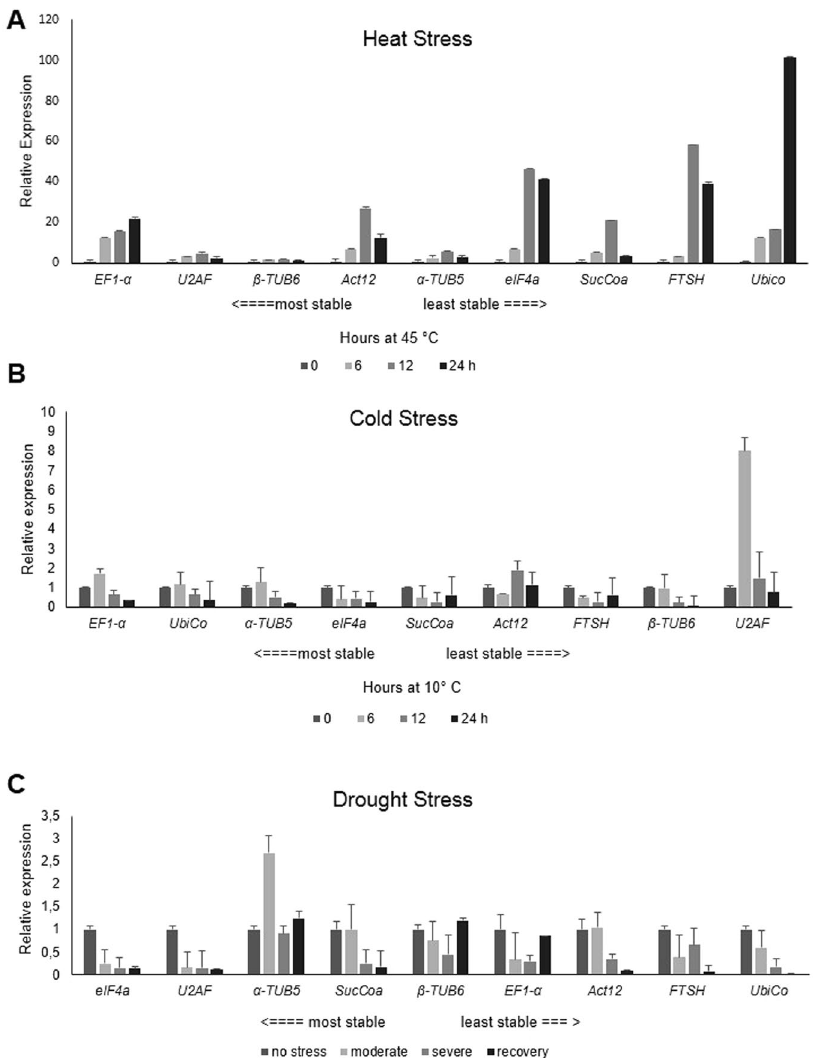
Figure 5. Relative expression of the rbCl gene in leaves of U. brizantha cv. Marandú under three abiotic stresses normalized to reference genes ranked according to the RefFinder approach: A – heat, B – cold and C - drought. The results are expressed as mean fold in change in relative expression compared to control samples. Bars indicate the standard error ( ± SE) calculated from three biological